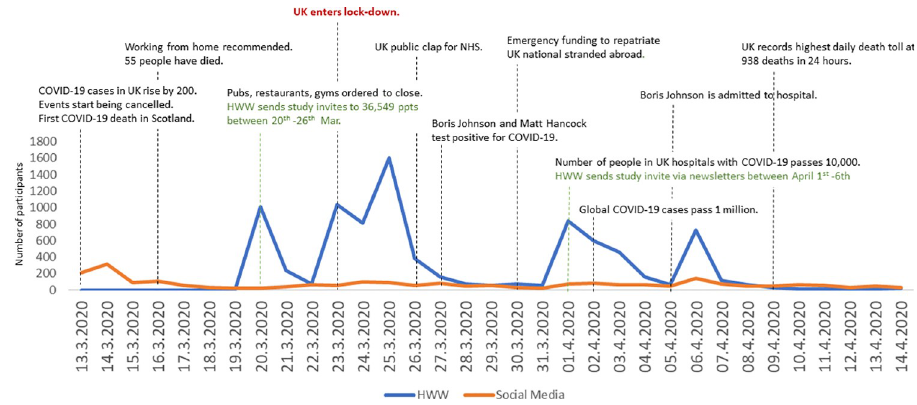
Fig 1. Number of participants completing the COPE survey via the HealthWise Wales (HWW) and social media (SM) routes on each day of the baseline recruitment period.